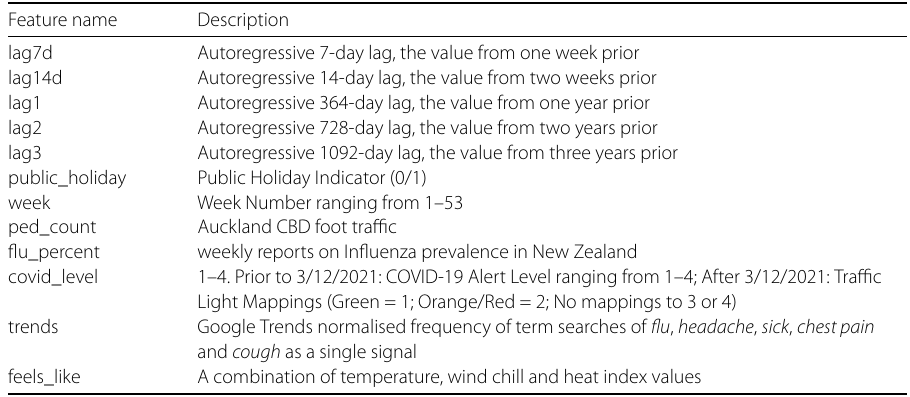
Table 2 Feature names as they appear in figures and their